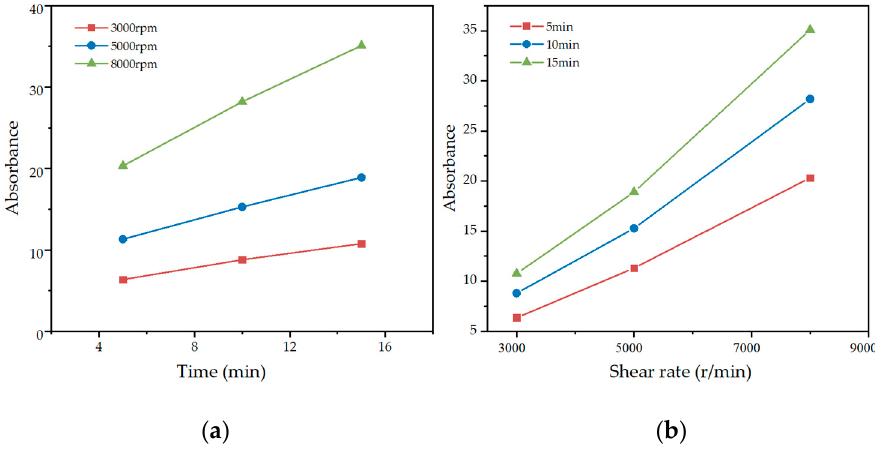
Figure 6. Absorbance of GNPs suspension; ( a ) different shear time; ( b ) different shear rates.